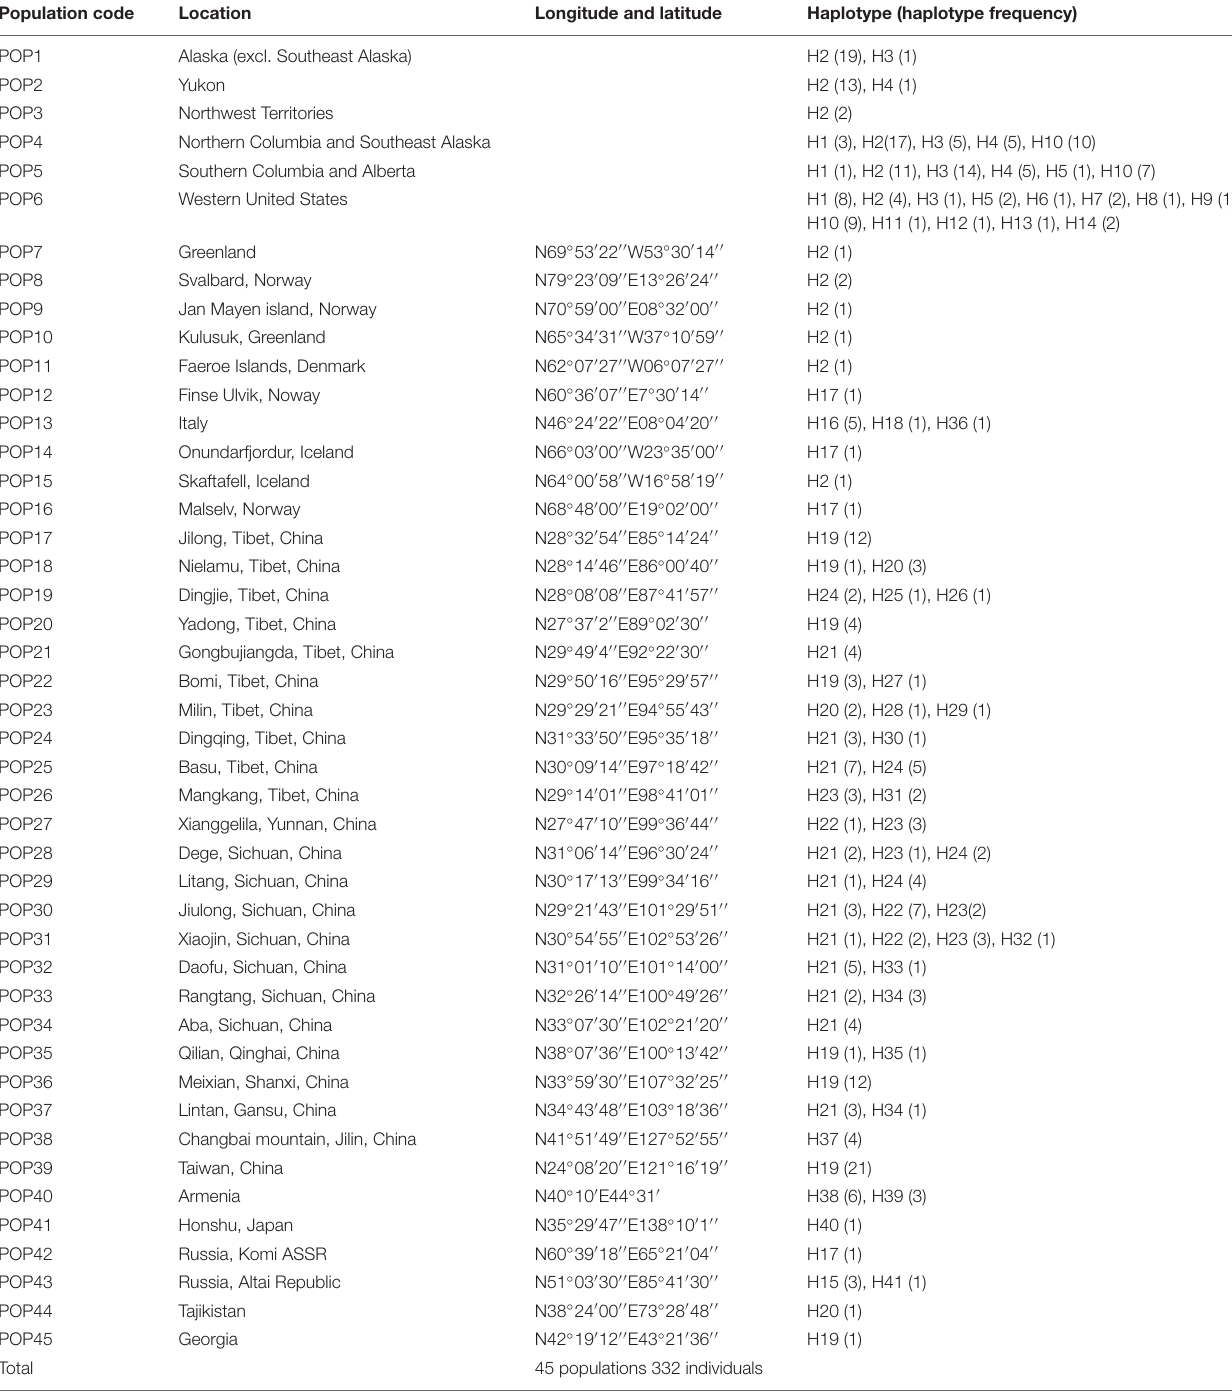
TABLE 2 | Sample locations, size, and haplotype frequencies. Population code Location Longitude and latitude Haplotype (haplotype